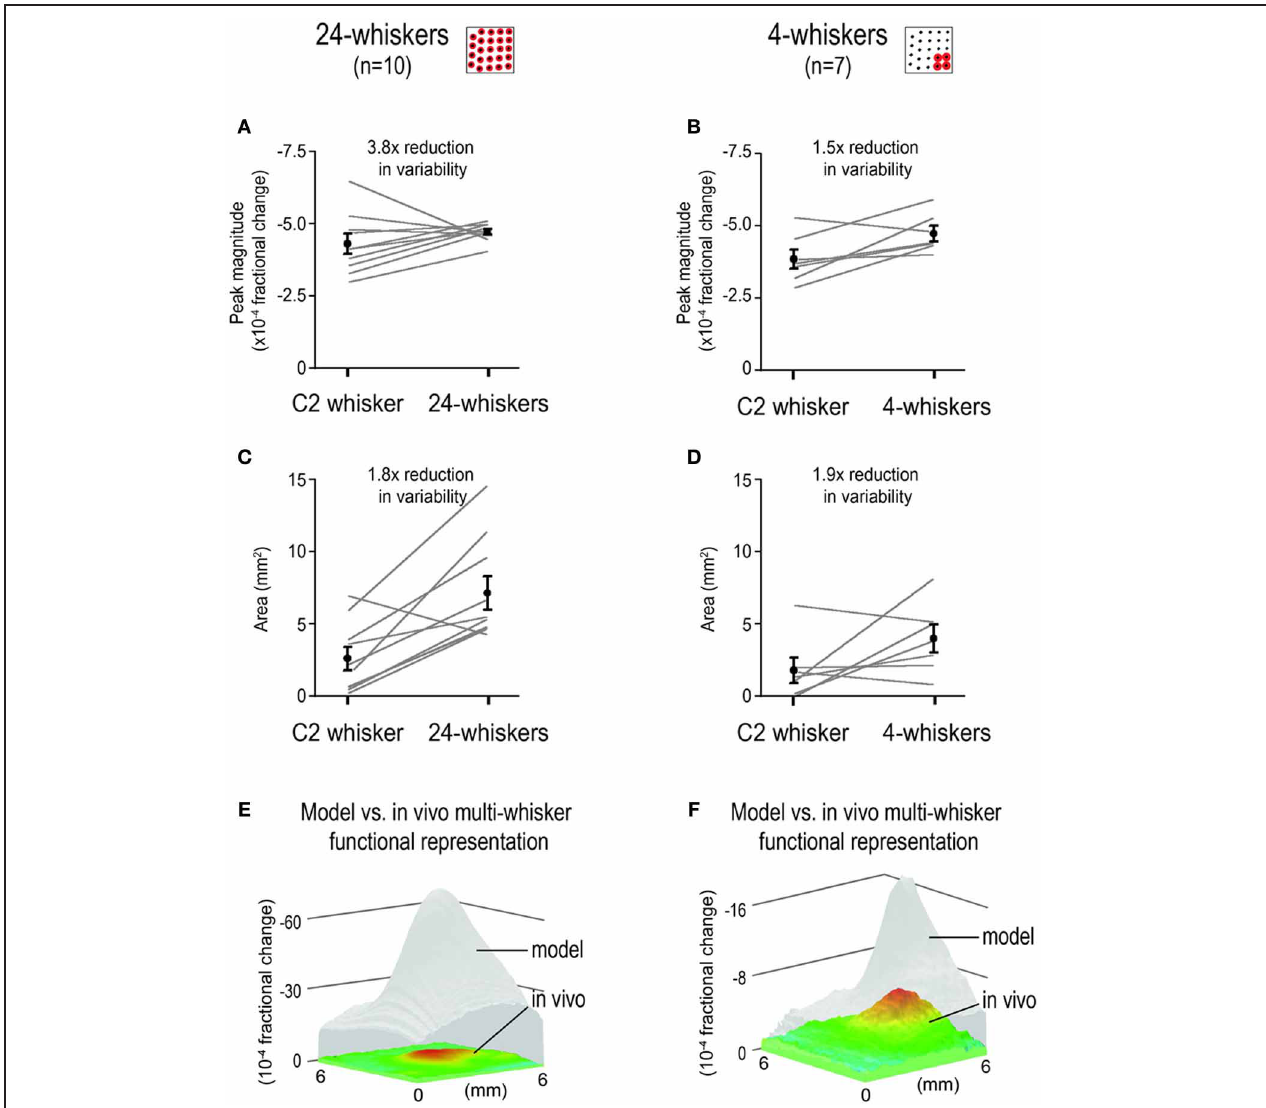
peak activity. The coefficient of variation (ratio between mean and variance) is used as a measure of degree in response variability. Note the reduction in response variability for the MWFRs as compared to the SWFR for whisker C2, particularly apparent for the peak magnitude of the 24-whiskers MWFR in panel (A) . (E,F) Activity mountains plotted on the same z-scale range to illustrate that the MWFR obtained in vivo (color) is much weaker than predicted by modeling based on simple linear summation (transparent